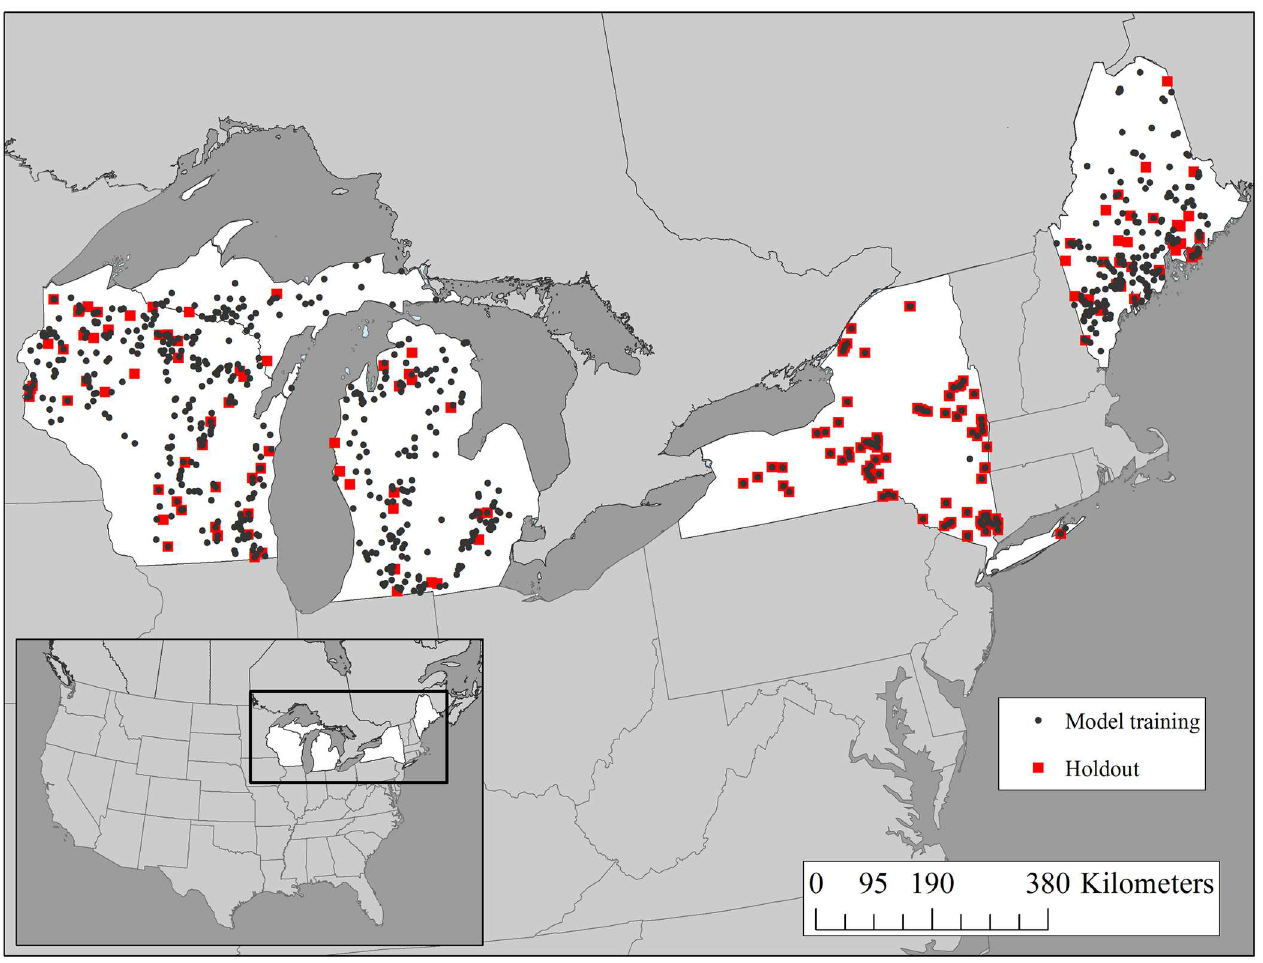
Fig 1. Study extent map. Lake locationsin the analysis(N = 838 lakes) includingmodel training observations (n = 6656) and locations of holdout observations for model predictive performance (n = 739). Lakes in New York were sampled through time and thus some observations were part of the model training dataset and other observations were part of the model predictive performance holdout